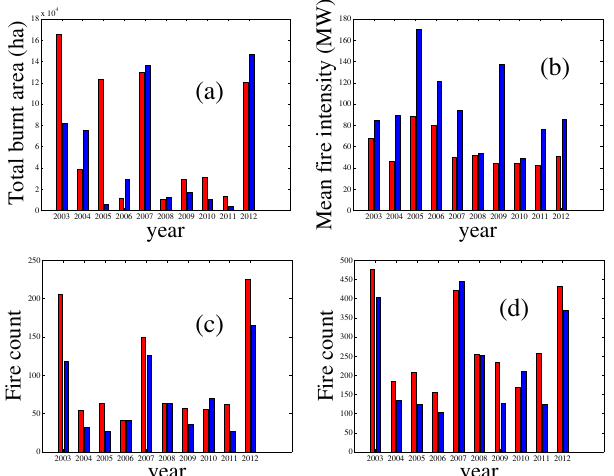
Figure 5. Total burnt area (a) , fire intensity (b) and fire counts asso- ciated with BA (c) and FRP (d) detection for HWM (red) and WFM (blue). BA detection is done using the MODIS MCD64